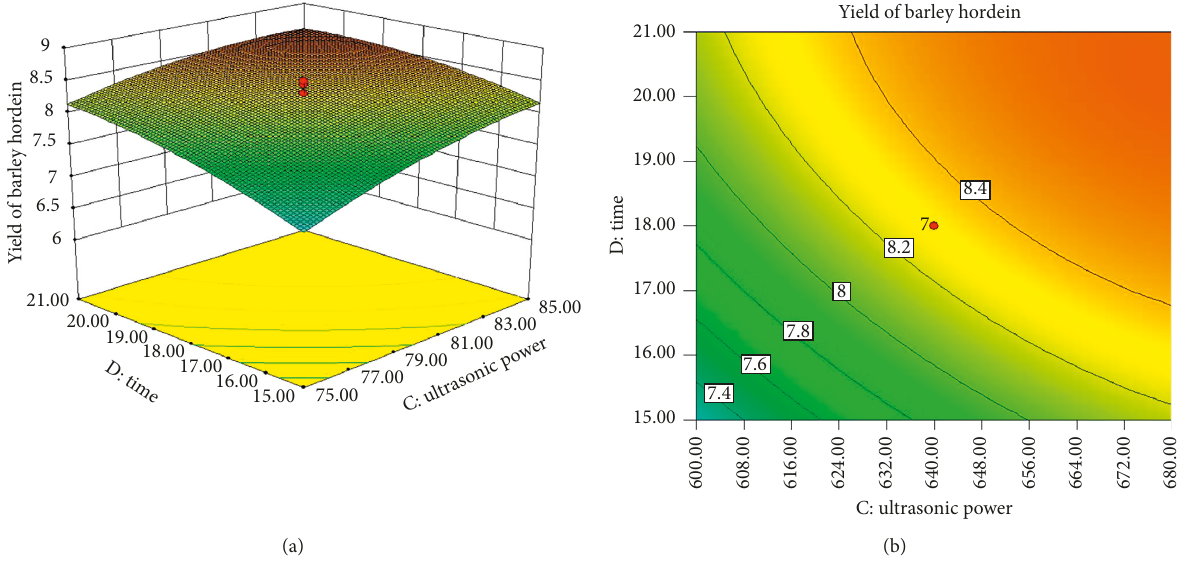
Figure 5: Contour plot showing the effect of ultrasonic power and extraction time on the yield of barley hordein at temperature of 65 ° C and microwave power 255W.